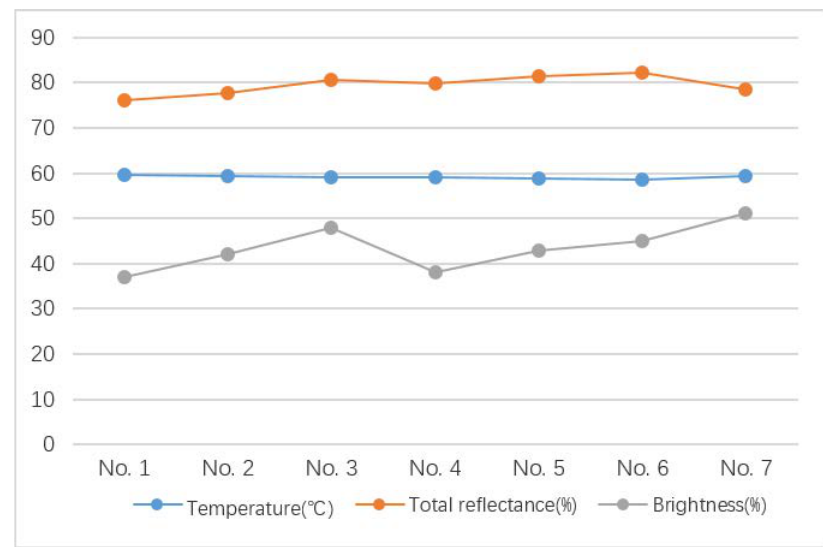
Figure 8. Box diagram of the temperature distribution of the coating